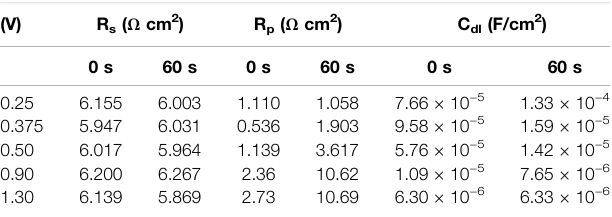
TABLE 1 | Fitting results of the Nyquist plots according to preconditioning time and applied potentials. (V) R s ( Ω cm 2 )